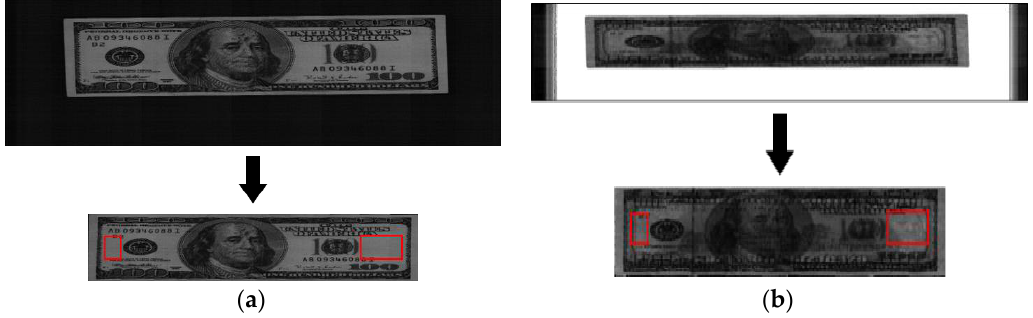
Figure 4. The banknote area extracted from the banknote image and the regions of interest: ( a ) VR image; ( b ) NIRT